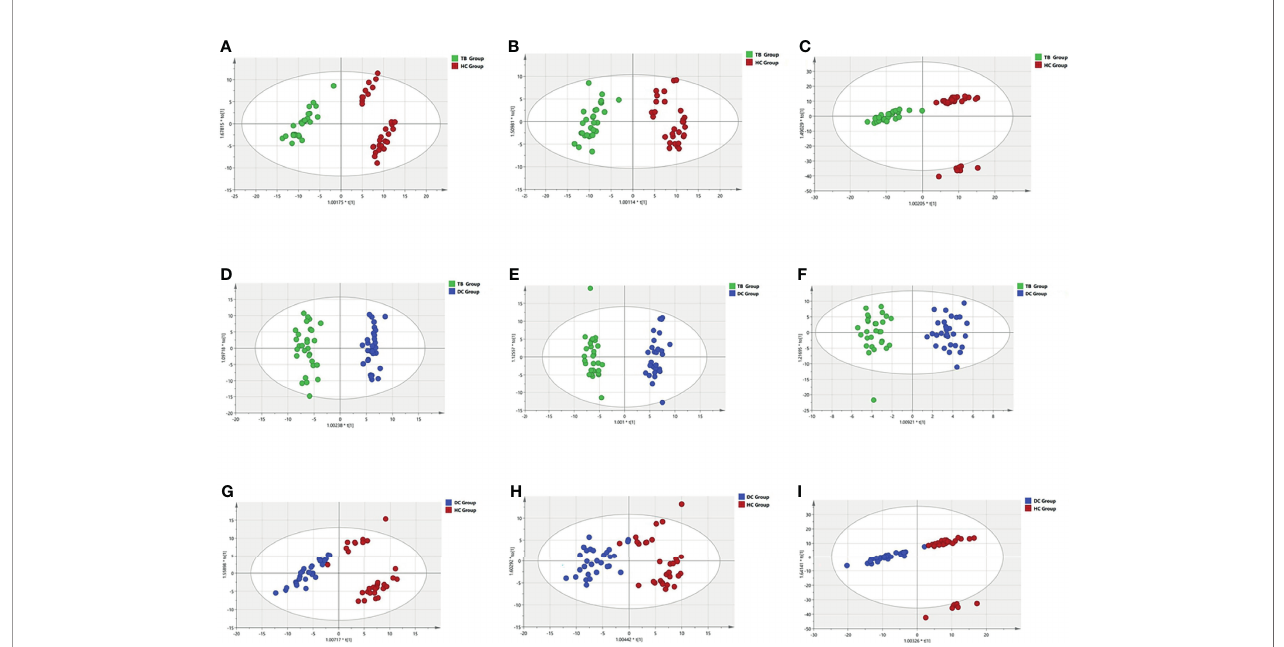
FIGURE 1 | OPLS-DA models of three patterns in three groups. (A, D, G) reversed-phase chromatography positive ion; (B, E, H) reversed-phase chromatography anion; (C, F, I) hydrophilic chromatography positive ion.